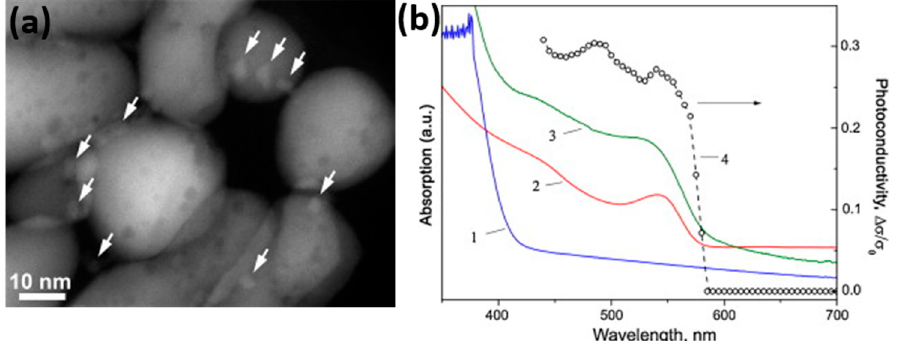
Figure 55. ( a ) High angular annular dark field scanning transmission electron microscopy (STEM) image of CdSe QD1/ZnO sample. CdSe nanoparticles are marked with arrows; ( b ) Absorption spectra of ZnO powder (1); CdSe QDs suspended in solution (2); QD3/ZnO powder (3); and dependence of photoconductivity of QD3/ZnO sample on the excitation wavelength (4). Reproduced with permission from [78].